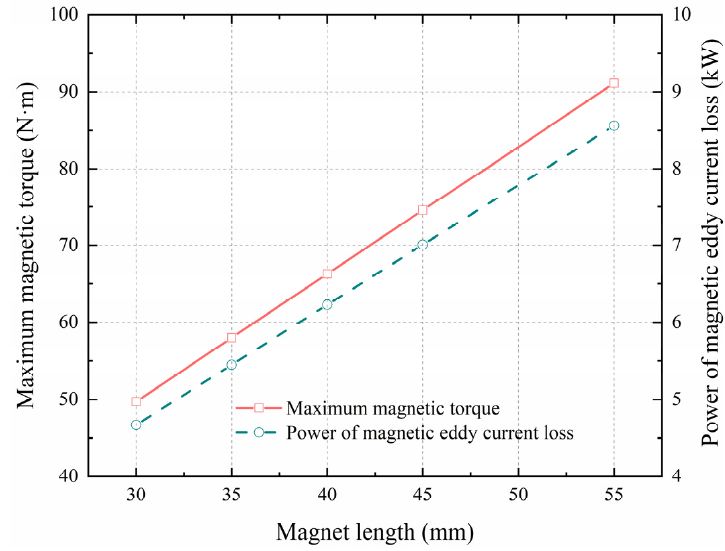
Figure 20. Magnetic torque and eddy current loss of different schemes.